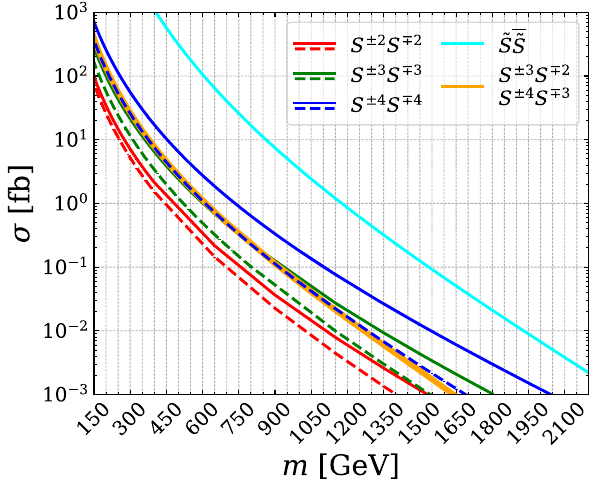
Fig. 3 The leading-order cross-sections of various production modes in Model-1 and -2. The dashed curves correspond to the cross-sections without the photon fusion process. The orange curve represents cross- sections for associated productions, pp → S ± 3 S ∓ 2 or S ± 4 S ∓ 3 (their cross-sections are the same), mediated by a s -channel W -boson. The cyan curve shows the QCD cross-sections of the single pair pro- duction mode in Model-2, i.e. pp → ˜ S + 4 / 3 ˜ S − 4 / 3 , ˜ S + 7 / 3 ˜ S − 7 / 3 and ˜ S + 10 / 3 ˜ S − 10 /